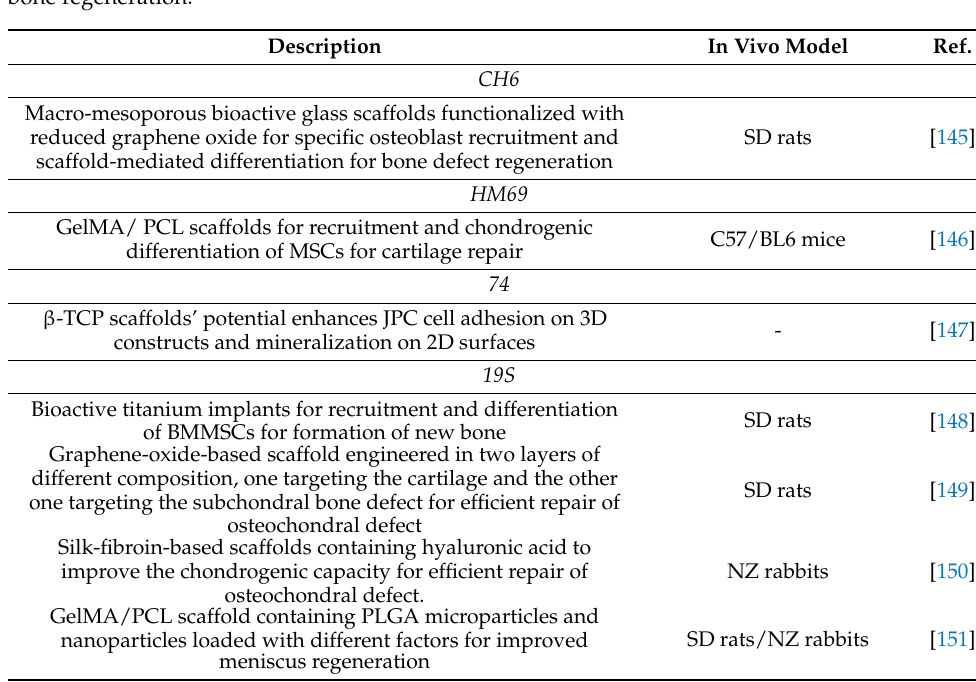
Figure 9. Example of photocrosslinkable bioink combined with PCL and functionalized with the ap- tamer 19S and growth factor. ( A ) Fabrication scheme. ( B ) Images of final scaffolds’ structure. ( C ) Mag- netic resonance imaging (MRI) of the different groups. Adapted with permission from [151] (Wiley). Table 4. Summary of the research articles that describe the use of aptamer-decorated scaffolds for bone regeneration.